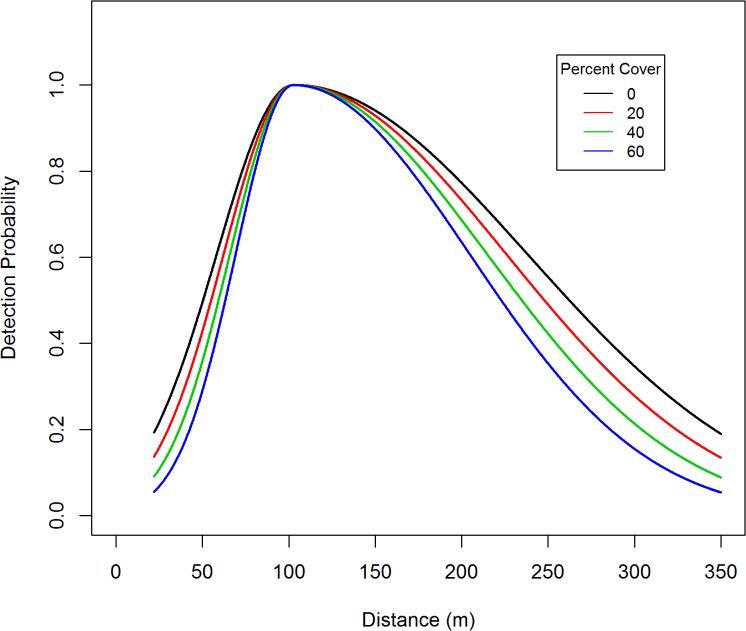
The effect of vegetative cover on average covariate detection of black bears in the Skwetna study area of South-Central Alaska.